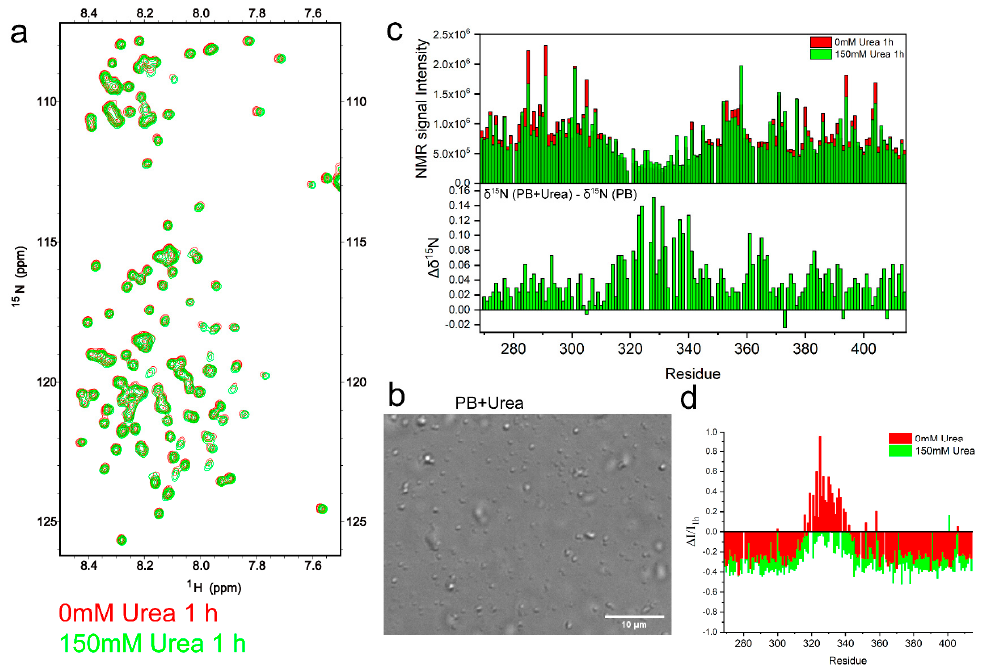
Figure 4. The effect of 150 mM urea on TDP-43 LCD liquid–liquid phase separation and protein aggregation. ( a ) The 1 H- 15 N HSQC spectra of TDP-43 LCD obtained within 2 h from sample preparation at a protein concentration of 100 μ M in pH 6.0, 10 mM phosphate buffer with 150 mM urea (in green) or without urea (in red). The temperature was 25 ℃ . ( b ) DIC image of 100 μ M TDP-43 LCD in PB buffer with 150 mM urea. ( c ) (Top) Comparison of the NMR signal intensity from 1 H- 15 N HSQC spectra in (a) with (green) or without (red) urea. (Bottom) 15 N chemical shift changes ( Δδ 15 N) of TDP-43 LCD (100 μ M) upon the addition of 150 mM urea in pH 6.0, 10 mM phosphate buffer. Δδ 15 N = δ 15 N (PB + Urea) −δ 15 N (PB). ( d ) NMR signal loss ratio ( Δ I/I 1h ) over time. Δ I = I 22h (NMR signal intensity after ~22 hours) − I 1h . Samples contained 150 mM urea shown in green or without urea shown in red.